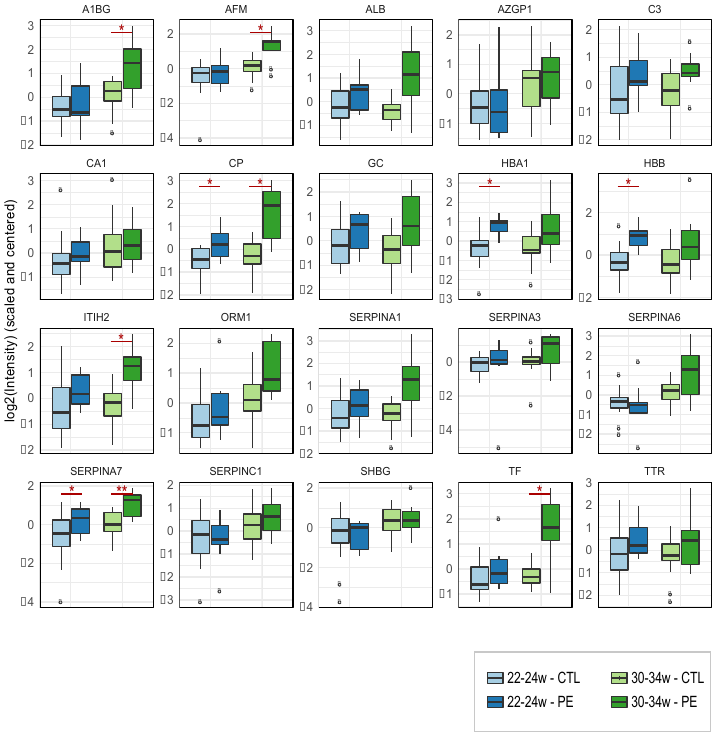
Figure 5. Longitudinal study: Distribution of intensities measured by targeted proteomics of 21 urinary proteins in women with and without preeclampsia at 20–24 or 30–34 weeks of gestation. The boxplots represent the distribution of intensities in each group as well as the median (line), the interquartile (box) and the maximum and minimum values within 1.5 times the interquartile range (whisker) of 21 proteins monitored by targeted proteomics in urine samples collected at 20–22 weeks (blue) and 30–32 weeks (green) of gestation in women with preeclampsia ( n = 9) (dark color) or women with uncomplicated pregnancies ( n = 20) (light color). Statistical significance is displayed above each graph: * p < 0.05; ** p < 0.01.